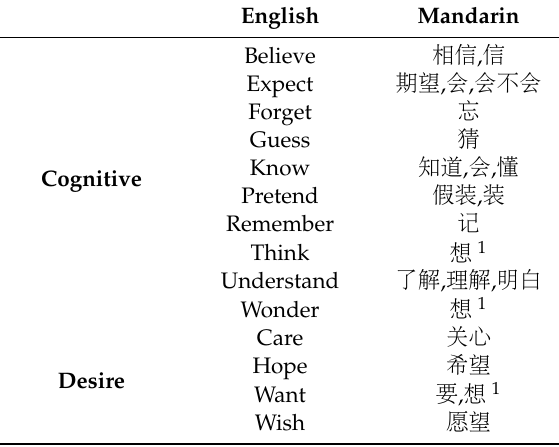
Table 1. List of English mental state words and their Mandarin translated counterparts. English Mandarin Believe 相 信 ,